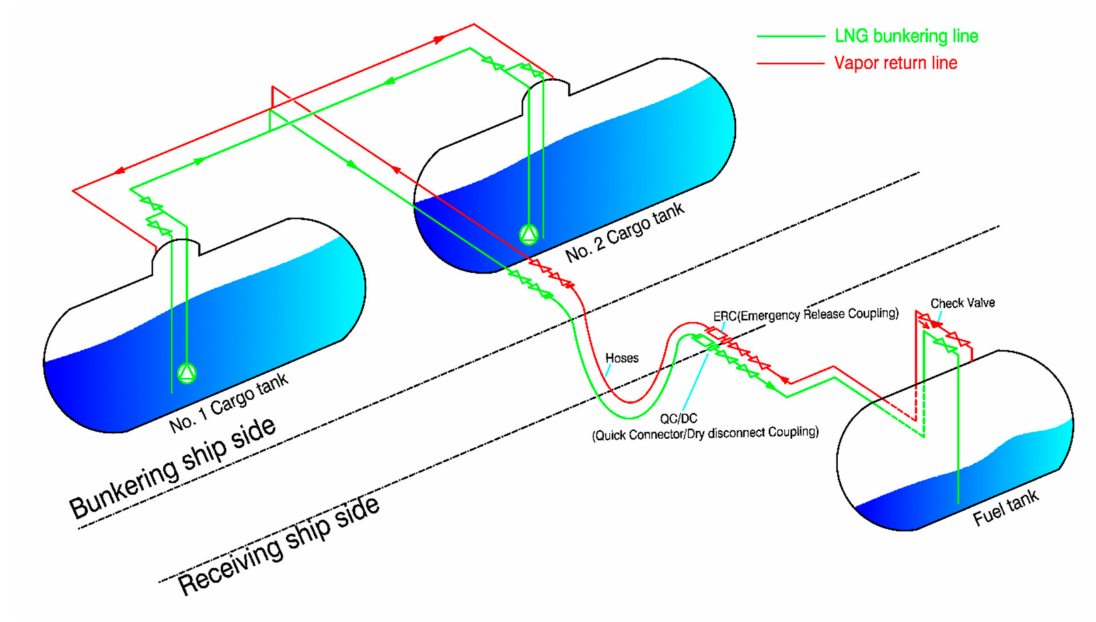
Figure 2. Schematic isometric view of ship-to-ship